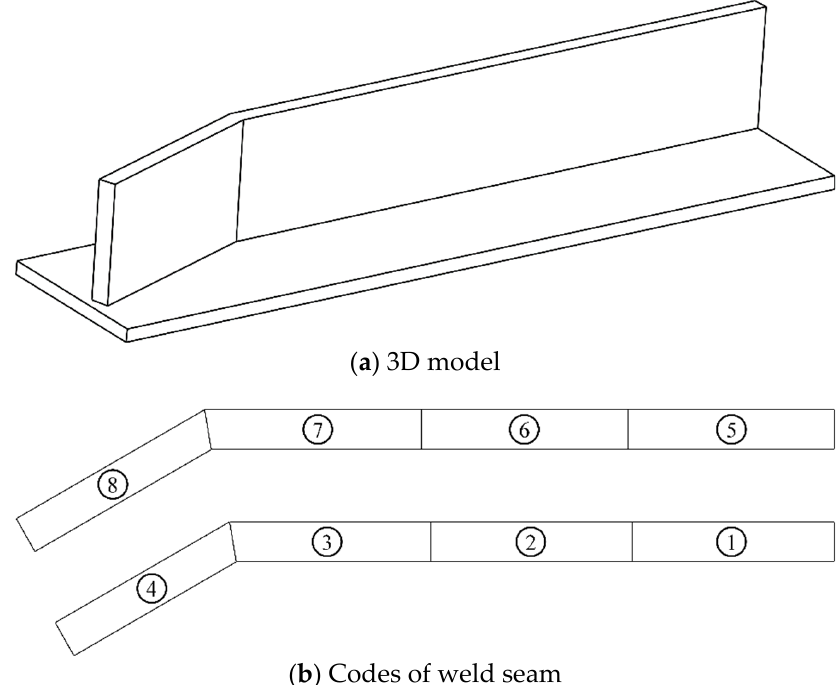
Figure 8. Weld seam coding of welded structure 2.